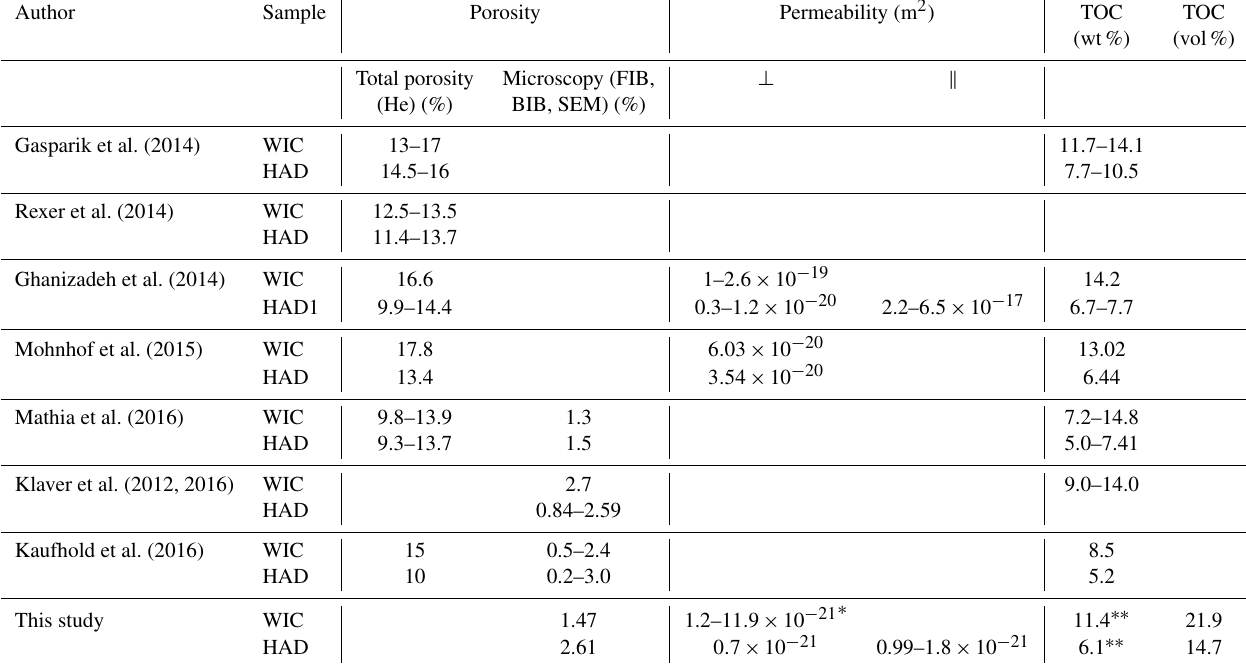
Table 1. Compilation of porosity, permeability and TOC data from recent Posidonia shale studies. ∗ Since the bedding plane was tilted, calculations were not performed strictly parallel or perpendicular to the bedding plane. ∗∗ TOC contents in wt% were estimated by assuming a density of 1.25gcm − 3 . ( ⊥ – permeability measured perpendicular to the bedding; (cid:107) – permeability determined parallel to the bedding; TOC – total organic